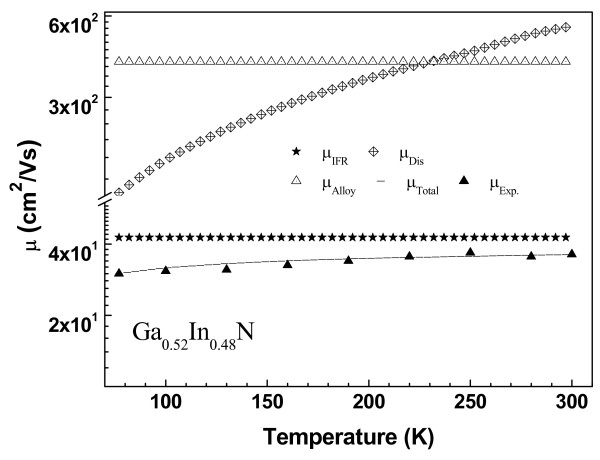
Measured and calculated mobility versus temperature Ga0.52In0.48 N.